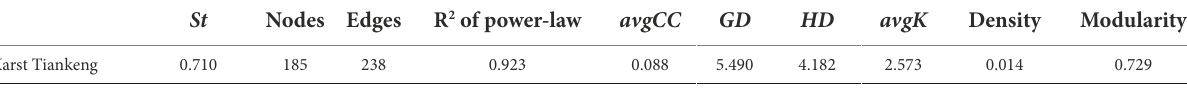
TABLE 2 Topological properties of microbial networks in five karst tiankengs. St Nodes Edges R 2 of